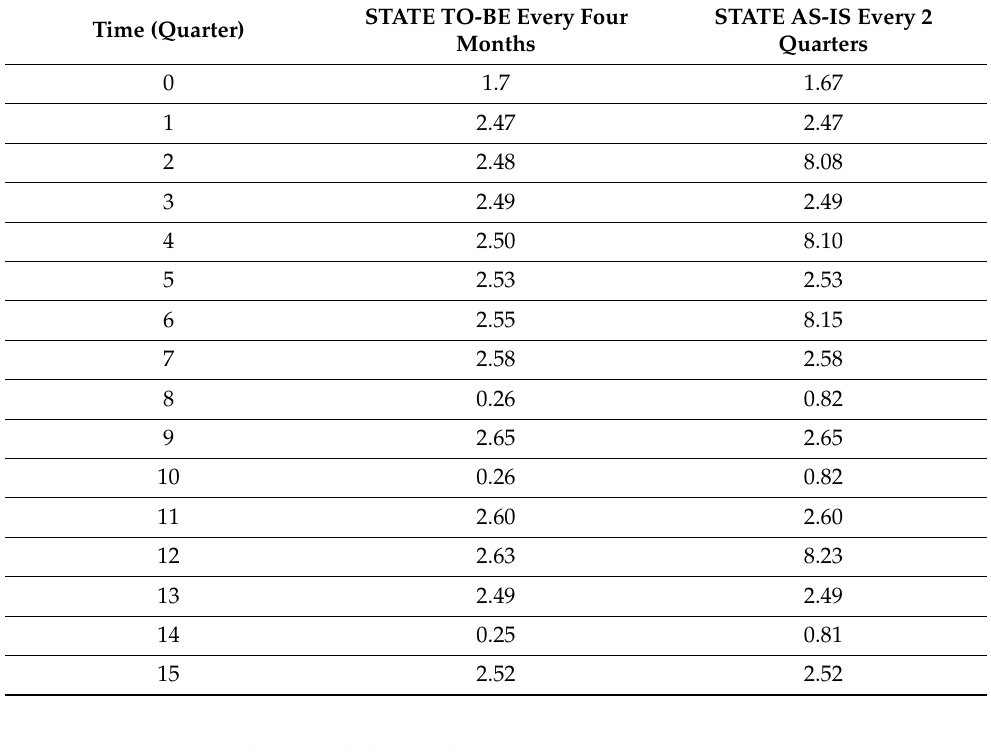
Table 4. AS-IS machine failure rate comparison.